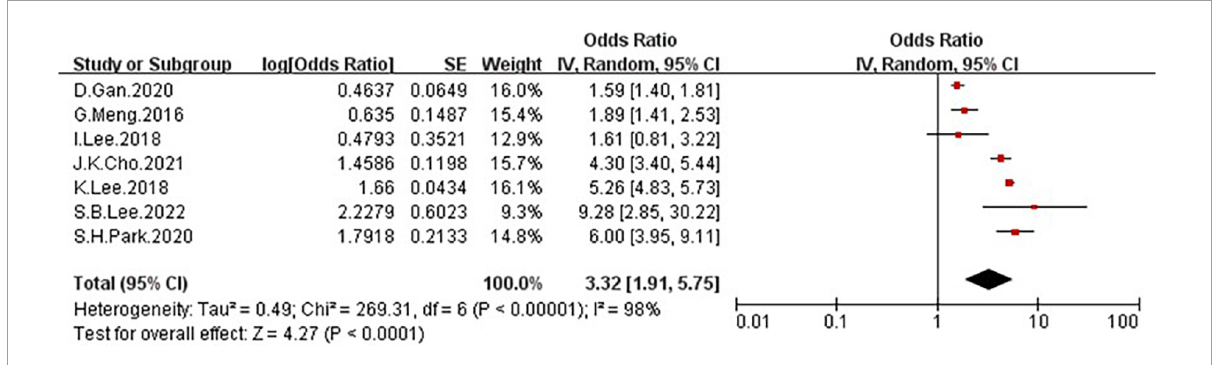
FIGURE4 Forest plots showing the relation between low grip strength and risk of NAFLD.